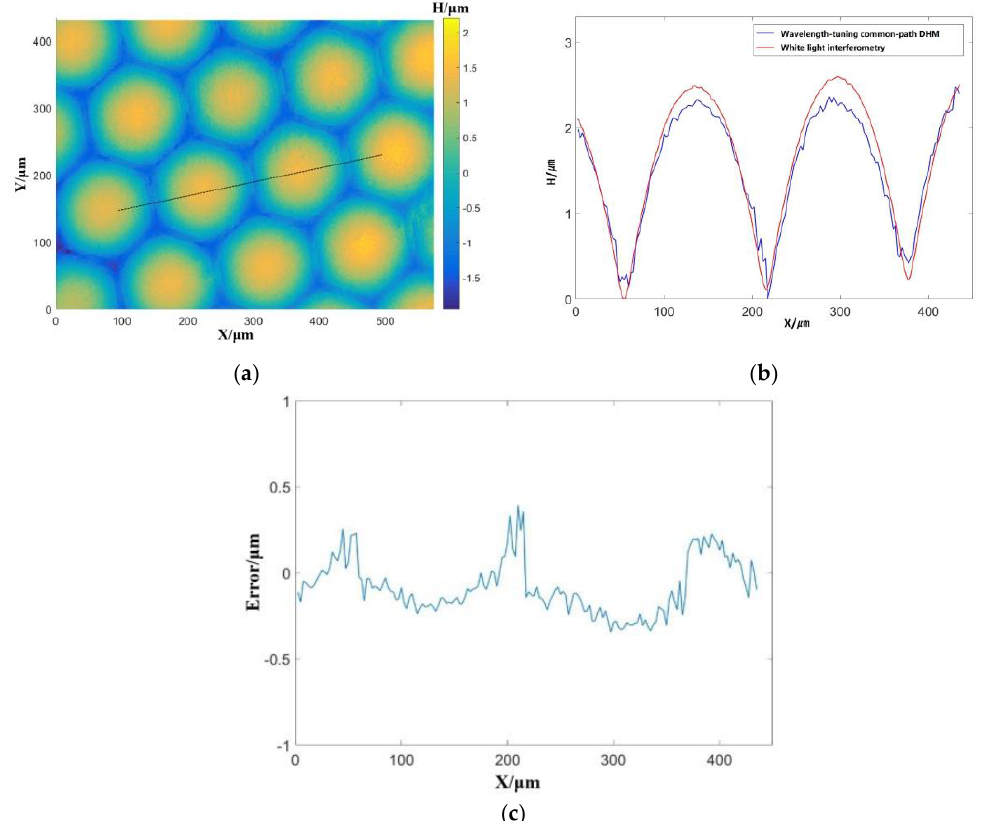
Figure 7. Measurement results for the micro-lens array, including ( a ) the 2D map, ( b ) a profile map along the dashed line shown in ( a ), and ( c ) the residual error.